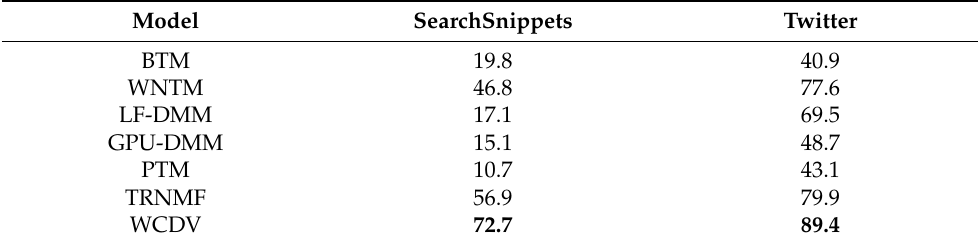
Table 7. Classification accuracy (%) evaluation using Short text datasets.